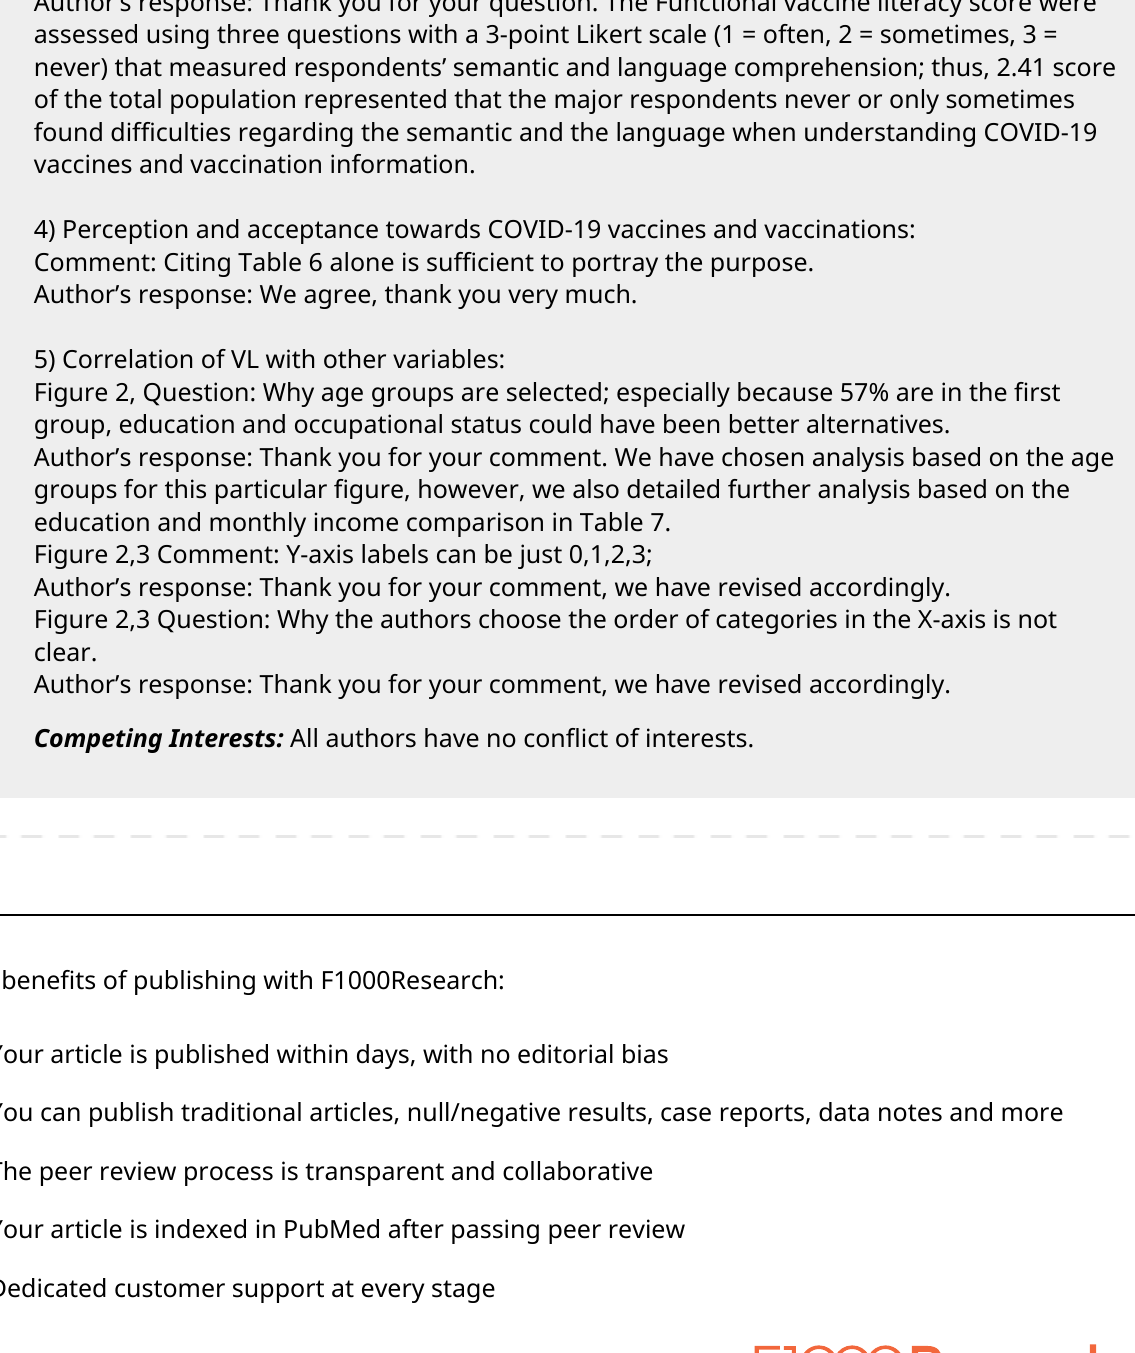
Table 5, Question: Functional vaccine literacy score for the total population is 2.41. Is that a good score? Is it comparable?